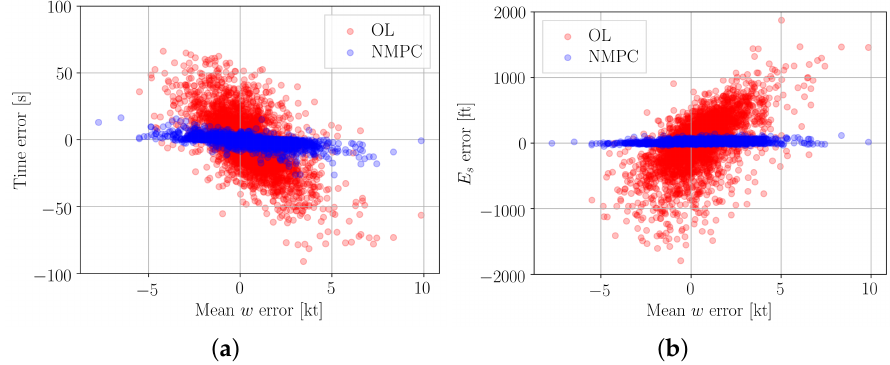
Figure 8. Time and specific energy error at the metering/merging fix. ( a ) Time error. ( b ) Specific energy